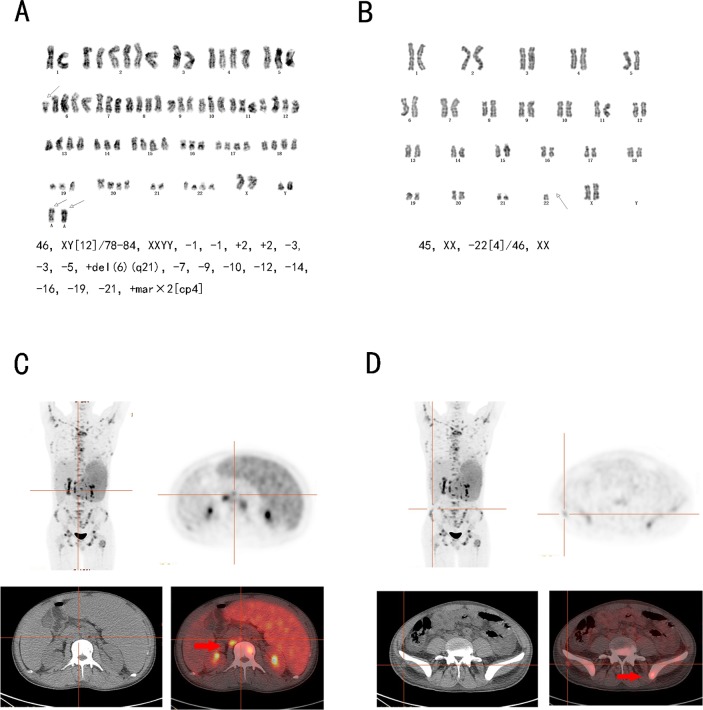
Patients with ANKL had highly complex karyotypes and could be tracked by 18-FDG-PET/CT.(A) Cytogenetic findings for patient 16, who had a hypotetraploid karyotype. (B) Cytogenetic findings of patient 18, who had a karyotype showing the loss of chromosome 22. (C) The 18-FDG-PET/CT result for patient 26 showed splenomegaly and internal lymphadenopathy with uniformly elevated metabolism, and the maximum SUV was 5.6. (D) Patient 26 showed non-uniformly elevated metabolism in the bone marrow, and the maximum SUV was 9.2.